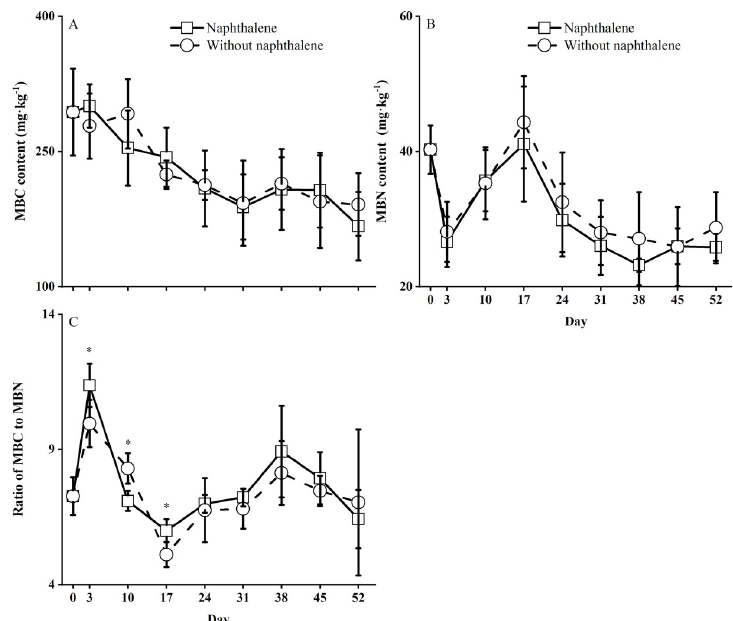
Fig 3. Soil microbial biomass contents in subalpine forest soil microcosms treated with and without naphthalene. The values represent the means ± the standard error (SE) (n = 5). Asterisks indicate significant ( � P < 0.05) differences between the treatments with naphthalene and without naphthalene at the same sampling time.